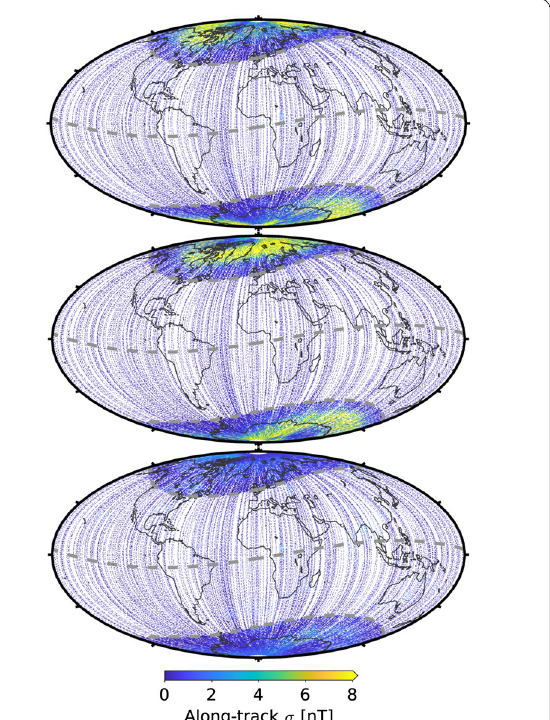
Fig. 2 Example along-track standard deviations for Swarm Alpha data during 2017, in the X, Y and Z vector components, from top to bottom. Data are smoothed for visualisation as the median of values binned in approximately 0.5 ◦ equal-area tessera (empty tessera are white). Contours of geomagnetic dipole latitude are marked at 0 ◦ and |55|